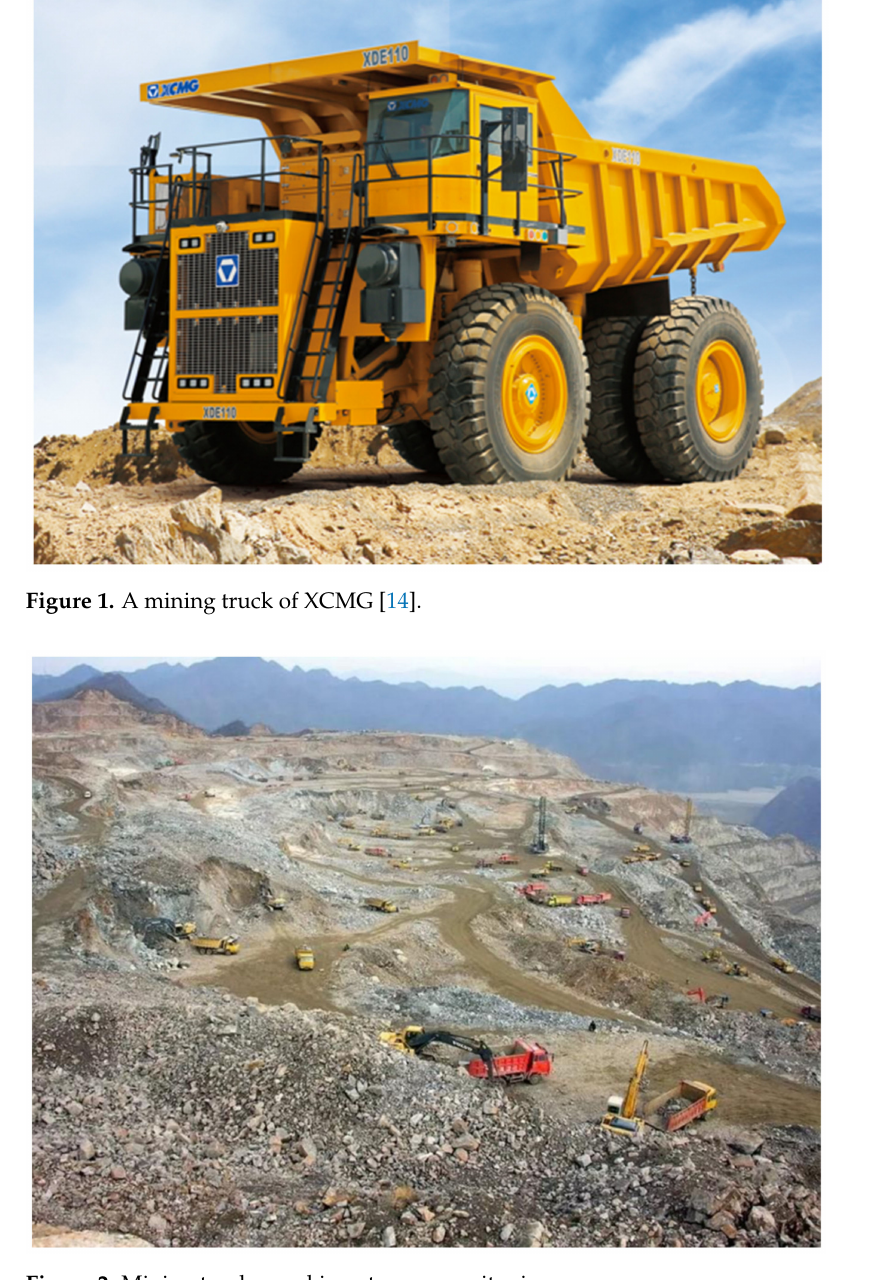
Figure 2. Mining trucks working at an open-pit